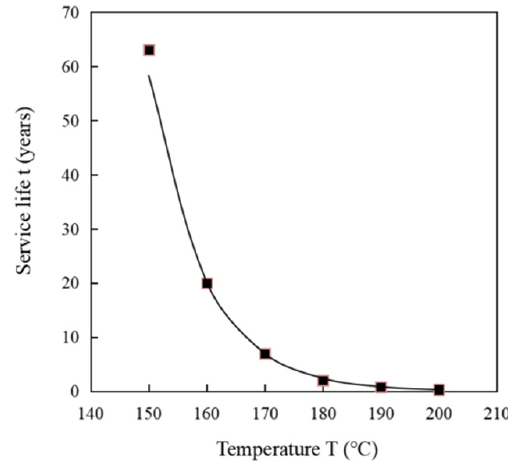
Figure 8. Service life at different temperatures.